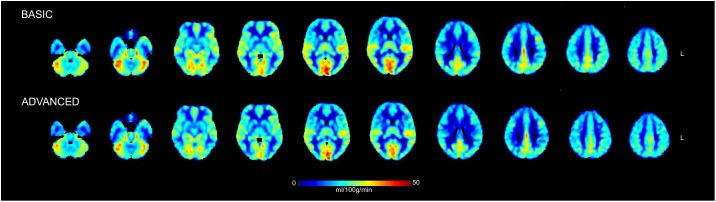
Mean cerebral blood flow (CBF) maps in physiological units (ml/100 g/min) calculated across the group of healthy controls from the ASL data cleaned with the basic and advanced pipelines. Some representative slices of interest in the 2-mm MNI152 standard space are reported in radiological convention. No statistically significant changes were detected between the CBF maps derived from the two pipelines when compared on a voxel-wise basis.